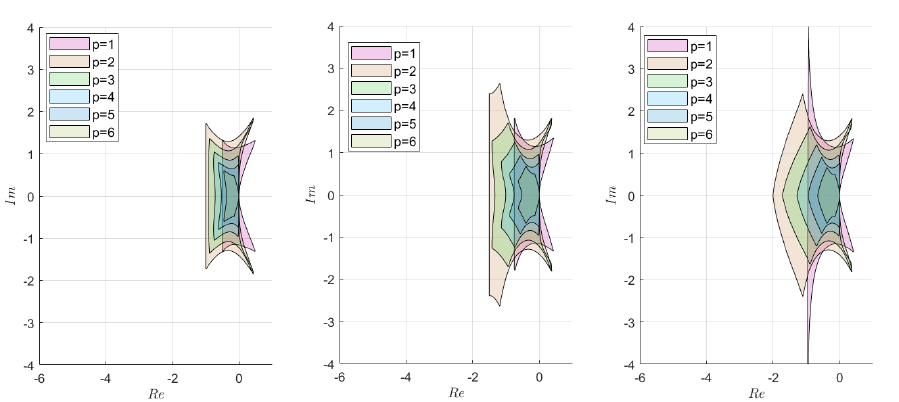
Figure 3. Stability regions of the semi-explicit ABM method with k = [ 0,0.5,1 ] (from left to